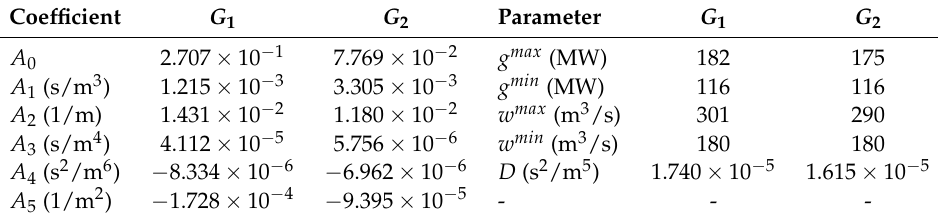
Table 4. Turbine efficiency functions’ coefficients, g ’s and w ’s bounds, and D values. Data from [11]. Coefficient G